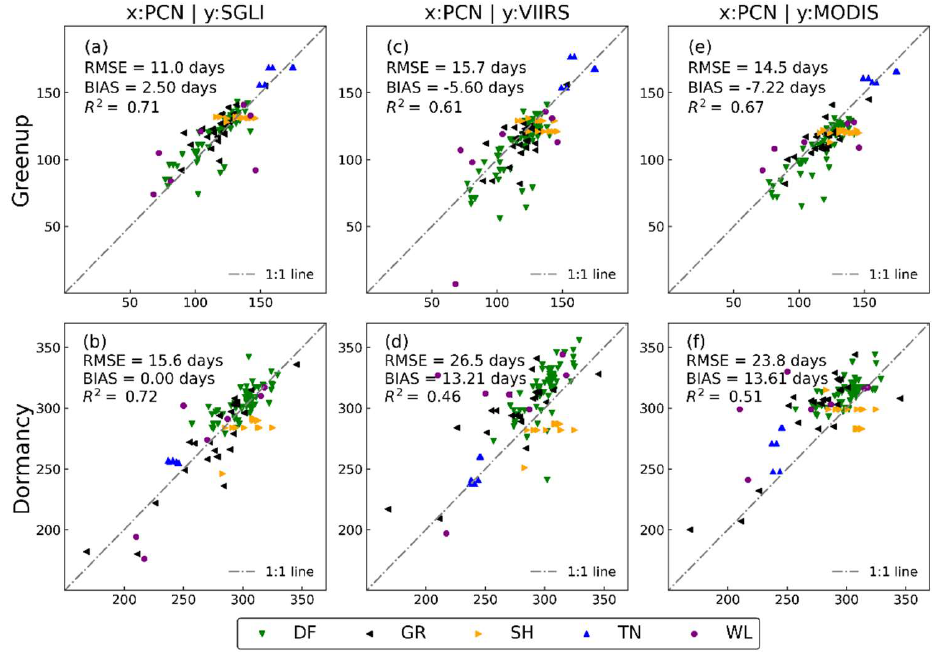
Figure 4. Comparison of green-up and dormancy dates from satellite (SGLI ( a , b ), VIIRS ( c , d ), and MODIS ( e , f )) and PCN observations by land cover types (DF: deciduous forest; GR: grassland, SH: shrub; TN: tundra; WL: wetland).